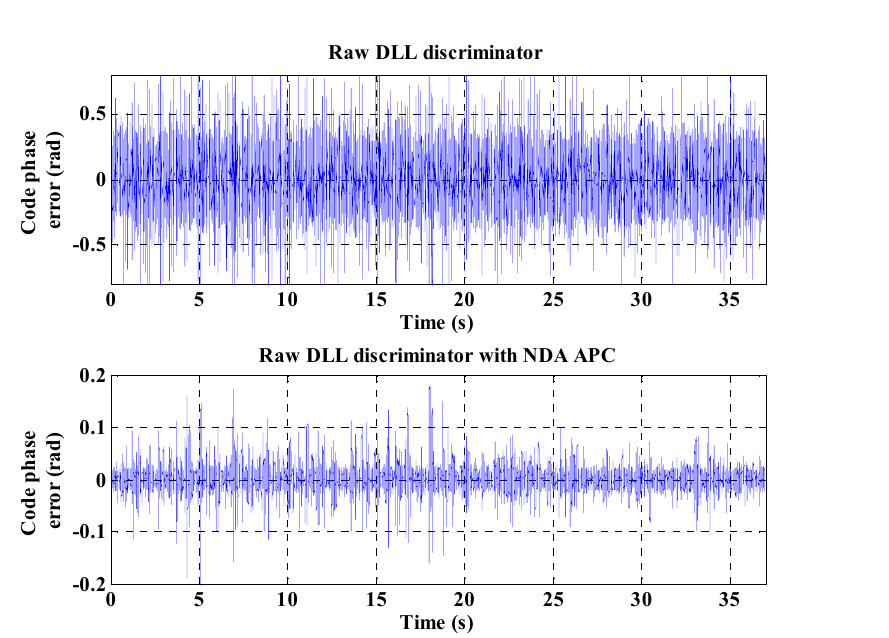
Figure 7 – Signals at the output of the discriminator (DLL) in the case of the Costas PLL (upper) and the NDA phase estimator (lower)